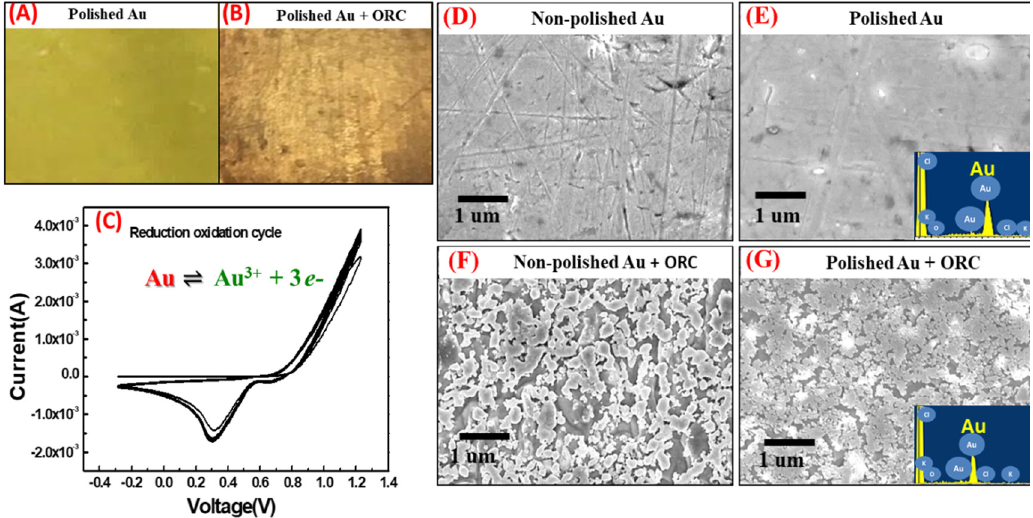
Figure 2. Optical microscopy images of Al-polished Au plate ( A ) without and ( B ) with ORC, ( C ) cyclic voltammogram of ORC process run with 30 cycles, FE-SEM figures of ( D ) non-polished and ( E ) polished Au plates without ORC, and non-polished ( F ) and polished ( G ) Au plate with